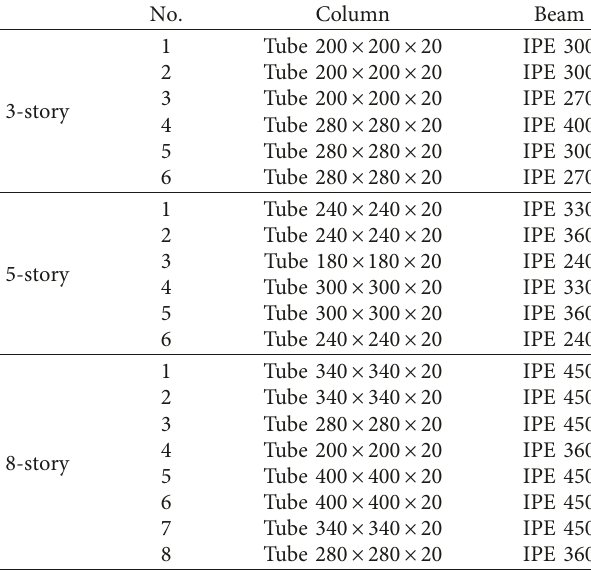
Table 1: Sections of 3-, 5-, and 8-story structures. No.